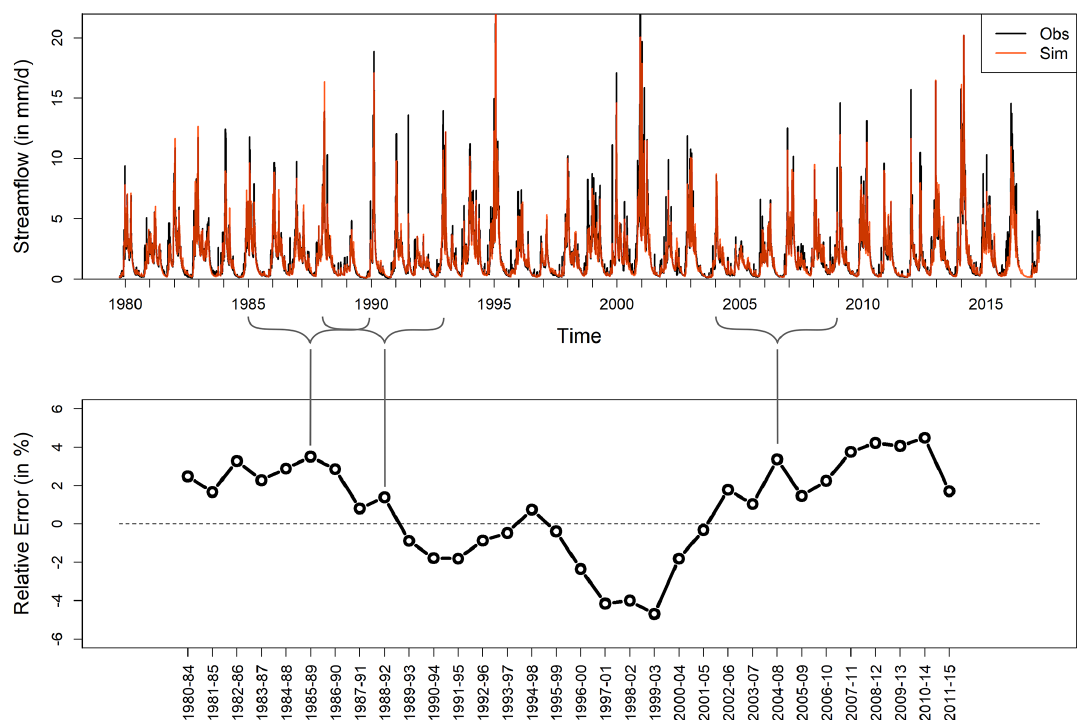
Figure 1. Construction of the moving bias curve. The top panel shows daily simulated (orange line) and observed (black line) streamflow. The bottom panel shows moving bias curve expressed as the relative error (in percent); each point of the curve corresponds to a 5-year sub-period of the time series (as exemplified by the